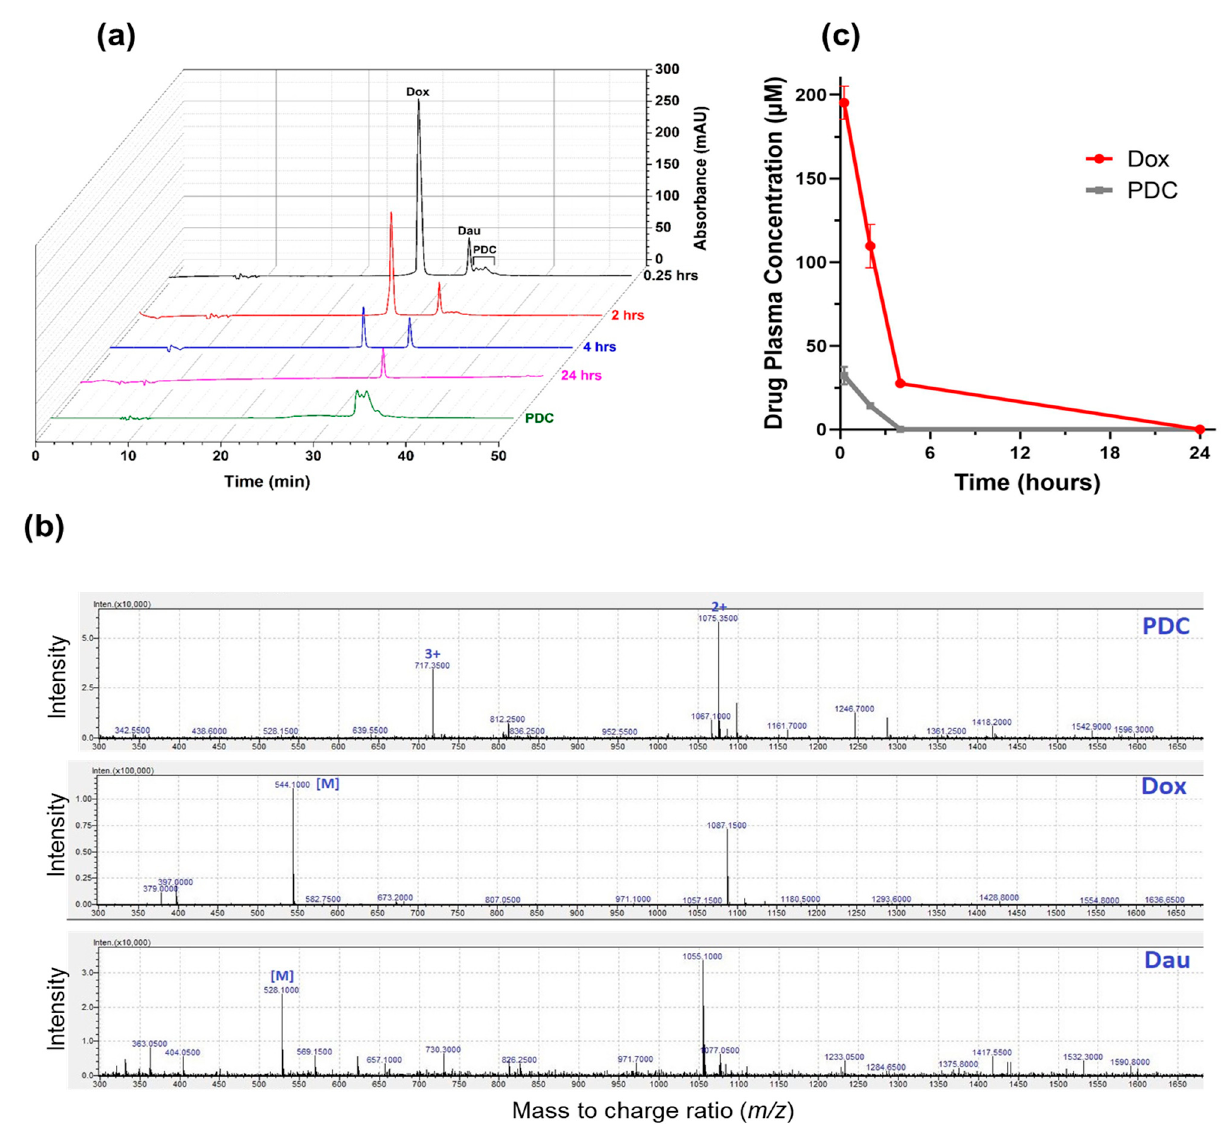
Figure 2. Concentration of total drug (PDC and Dox) after administration of PDC in female (8-week-old) nonobese diabetic—severe combined immunodeficiency (NOD-SCID) mice. Mice ( n = 3) were administrated PDC (2.5 mg/kg Dox equivalent or 0.088 ± 0.008 µ moles) via tail vein injection, and blood was collected via cardiac puncture at 0.25, 2, 4, and 24 h. The serum (100 µ L) from blood was collected. Serum was subjected to organic extraction, and the extract was injected in LC/MS system to detect and quantify PDC and released Dox. No other metabolites of Dox were observed. ( a ) Representative chromatograms for samples after extraction, monitored at λ = 481 nm. Dau was used as an internal standard. Chromatogram of pure PDC (280 µ M, 20 µ L) is shown for comparison; ( b ) Representative electrospray ionization (ESI) mass spectra of PDC, Dox, and Dau obtained during the LC/MS analysis of one sample out of three at 0.25 min. PDC shows two m/z peaks at 717.35 and 1075.35 with charges +3 and +2, respectively. The found mass (M) from these peaks for PDC was 2149.1 (calcd. 2148.7). For Dox and Dau, the found mass were 544.1 (calcd. 543.5) and 528.1 (calcd. 527.5), respectively; ( c ) Average serum concentration ( µ M) of PDC and Dox at each time interval obtained from the LC/MS data. Data shown is mean ±